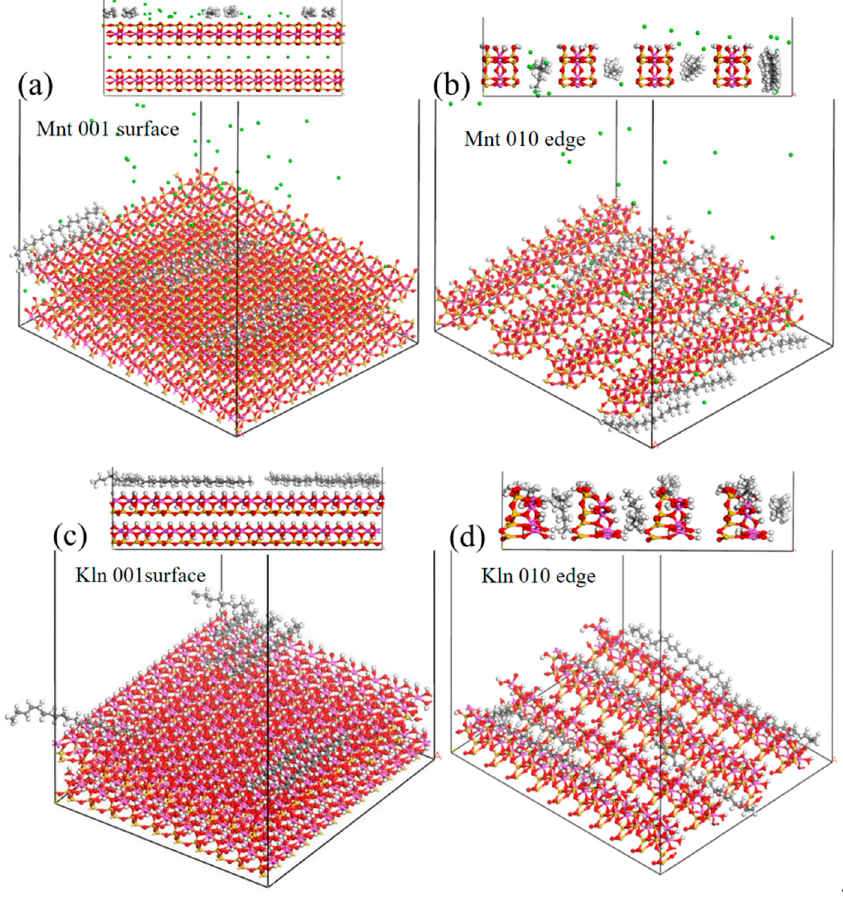
Figure 5. Equilibrium configuration structures of saturates adsorbed on ( a ) 001 surface and ( b ) 010 edge of Mnt and ( c ) 001 surface and ( d ) 010 edge of Kln at 298 K.